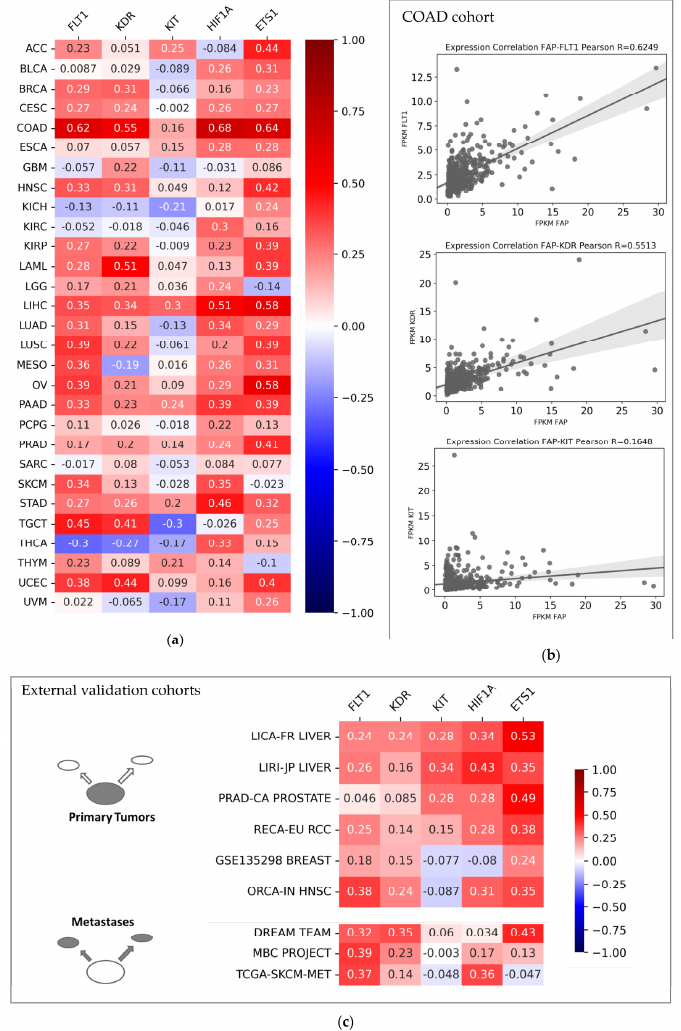
Figure 5. Pearson R values between FAP expression and FLT1, KDR, KIT, HIF1A, and ETS1 expression within ( a ) TCGA pan-cancer cohort and ( b ) specifically within colon adenocarcinoma (COAD cohort from TCGA database). ( c ) Pearson R values for respective genes in nine independent validation cohorts. FPKM: Fragments per Kilobase Million.